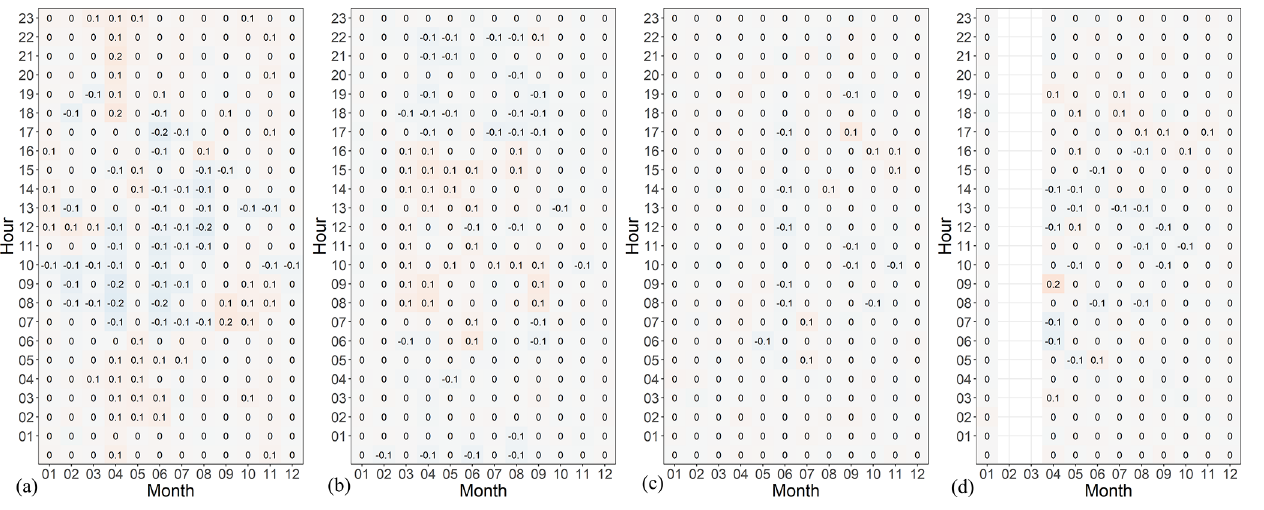
Figure 16. Same as Fig. 10 but for QC level